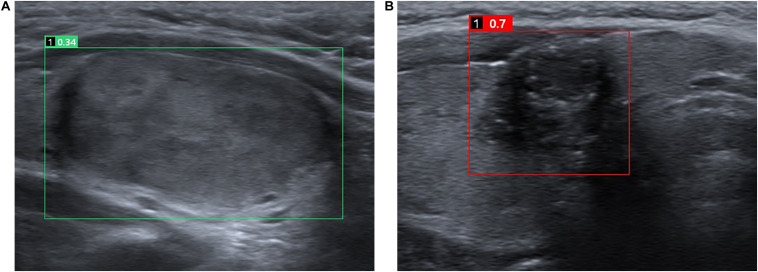
Representative cases of benign (A) and malignant (B) thyroid nodules. For the benign nodule (A), both the CAD system and the senior and the junior radiologists diagnosed it as a benign nodule. The CAD system rate the nodule of 0.34. For the malignant nodule (B), both the CAD system and the senior and the junior radiologists diagnosed it as a malignant nodule. The CAD system rate the nodule of 0.7.